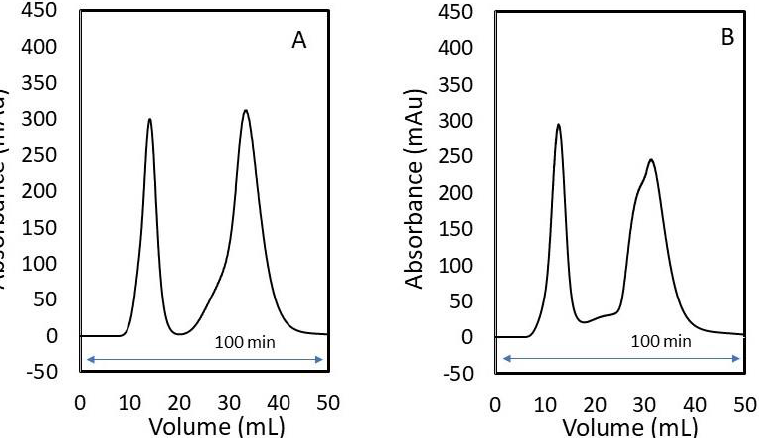
Figure 4. Chromatograms obtained during the separation of BSA (5 g/L) and lysozyme (2.5 g/L) using the ( A ) conventional (Tricorn GL 10/300) column and ( B ) the short and wide column (medium: Sephacryl S-200 HR; mobile phase: phosphate-buffered saline (pH 7.4); flow rate: 0.5 mL/min; loop size: 2 mL).